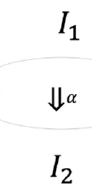
Figure 7. Isomorphism between two R-instances.